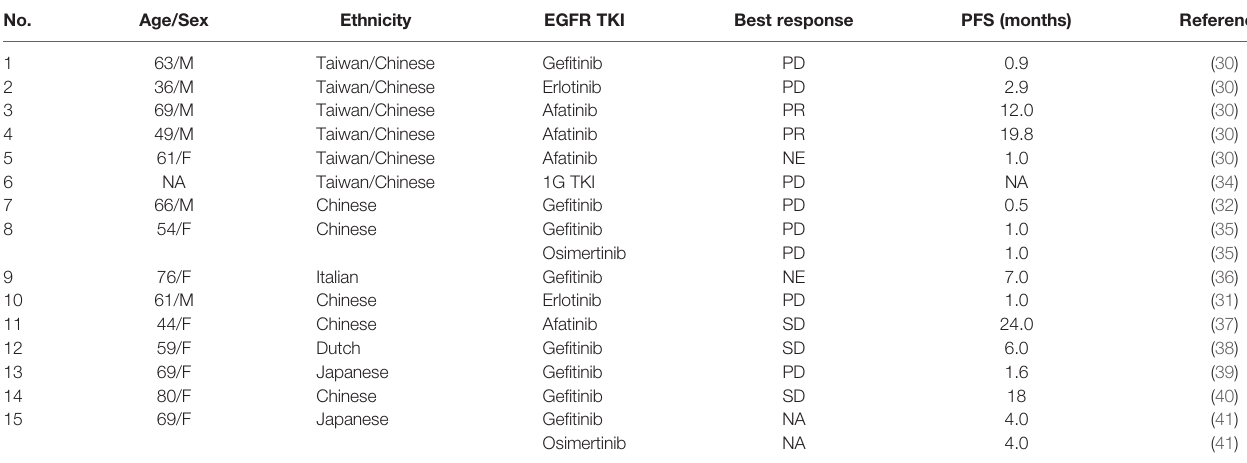
TABLE 1 | Responses to EGFR TKIs in NSCLC patients with p.L747P mutation from published reports.